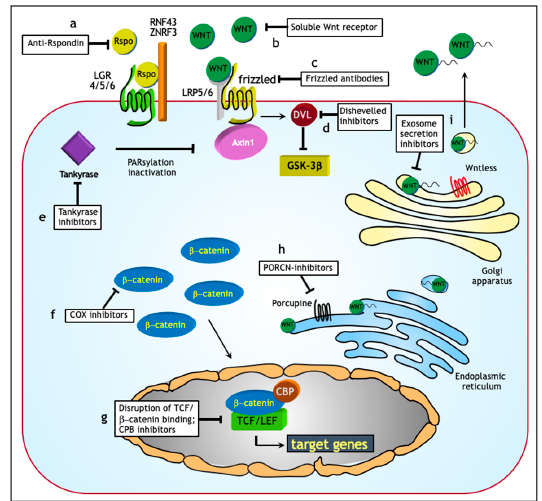
Figure 4. Therapeutic targets for the inhibition of Wnt signaling. ( a, b, c ) Wnt soluble receptors, anti- R-spondin antibodies, and antibodies directed against Frizzled receptors impair the ligand/receptor interaction and prevent downstream signaling. ( d ) Disheveled inhibitors block Wnt signaling by interfering with the Frizzled/Disheveled interaction. ( e ) Tankyrase activates Axin through PARsylation. Tankyrase inhibition increases Axin levels thus stimulating the formation of the β - catenin destruction complex and reducing the intracellular β -catenin pool. ( f ) cyclooxygenase (COX) inhibitors increase ubiquitination and proteasomal degradation of β -catenin. Next, COX2 inhibition leads to reduced levels of prostaglandin E2 (PGE2) known to positively affect Wnt signaling. ( g ) Disruption of its interaction with TCF inhibits β -catenin-mediated transcriptional activity. CREB- binding protein (CBP) inhibitors instead interfere with the interaction between TCF/LEF and CBP thereby reducing transcriptional activity. ( h ) PORCN -inhibitors hamper the palmitoylation of Wnt before its extracellular release. ( i ) Exosome secretion inhibitors reduce the transport of biomolecules like active Wnt ligands, RNAs and proteases that contribute to angiogenesis, tumor growth, immune response suppression, the remodeling and degradation of the extracellular matrix (ECM). Additional abbreviatons: RNF43 = RING finger 43; LGR4/5/6 = Leucine-rich repeat-containing G-protein coupled receptor 4/5/6; RSPO = R-spondin; ZRNF3 = Zinc RING finger 3; GSK3 β = glycogen synthase kinase 3 β ; LRP5/6 = LDL Receptor Related Protein 5/6; TCF/LEF = T-cell specific transcription factor/lymphoid enhancer binding factor.